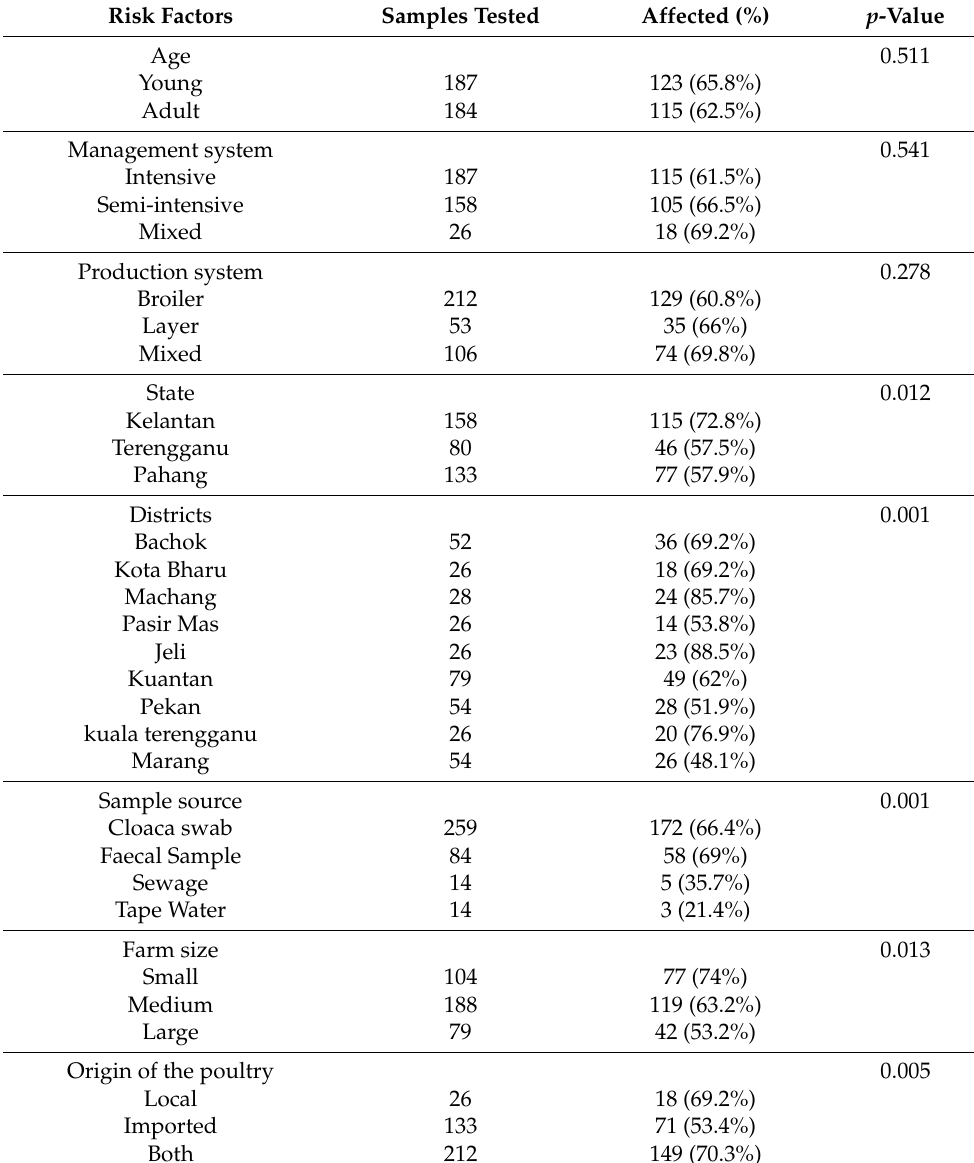
Table 1. Summary of risk factors of E.coli among poultry farms in the Kelantan, Terengganu and Pahang, Malaysia (n = 371) by using chi-square